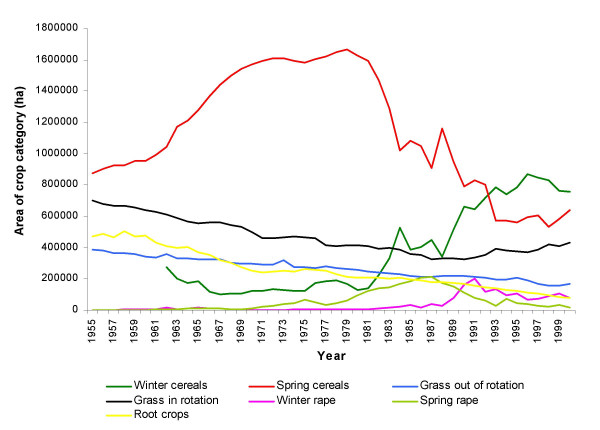
The total areas of the seven crop categories in Denmark 1955–2000. Note that prior to 1960 no data on winter cereals exist.